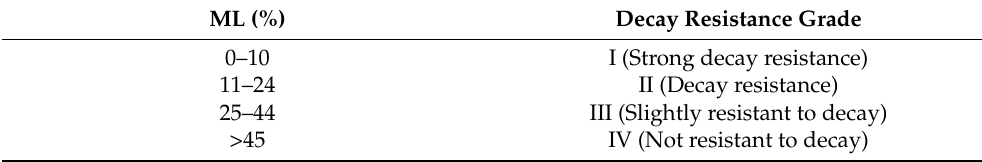
Table 1. Corresponding relationship between the mass loss and decay resistance